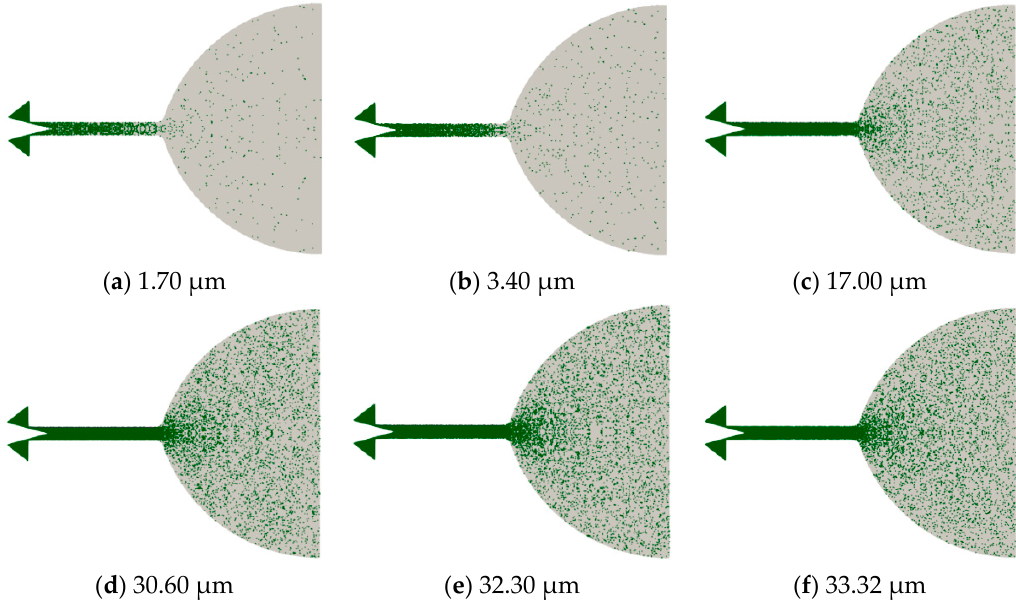
Figure 7. Particle distributions in the axial plane with different needle displacements at t = 0.1 ms. The calculation contours are mirrored on the axis of the symmetry axis.